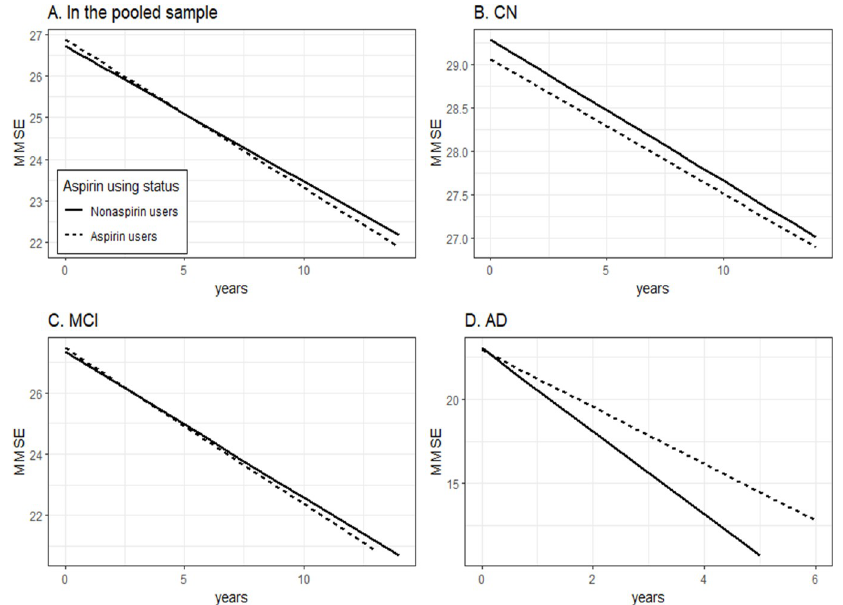
Fig 2. Association of baseline aspirin using conditions with change in MMSE scores over time. Compared to non- aspirin users, aspirin users showed a significantly slower decline in MMSE scores in the AD group (coefficient: 0.7004; p = 0.0024). However, we did find significant differences in changes in MMSE over time between two groups in the whole sample, CN or MCI group (all p > 0.05). Abbreviations: CN: cognitively normal; MCI: mild cognitive impairment; AD: Alzheimer’s disease; MMSE: mini-mental state